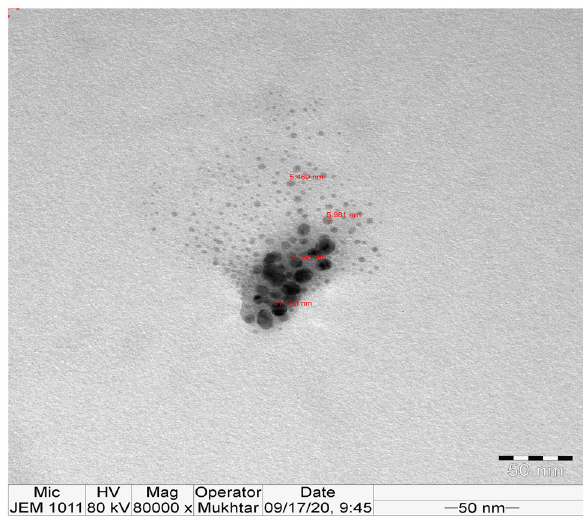
Figure 5: TEM image of phytosynthesized Ag -